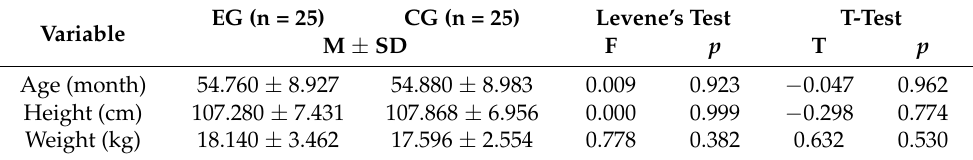
Table 2. Male subject variance homogeneity test.